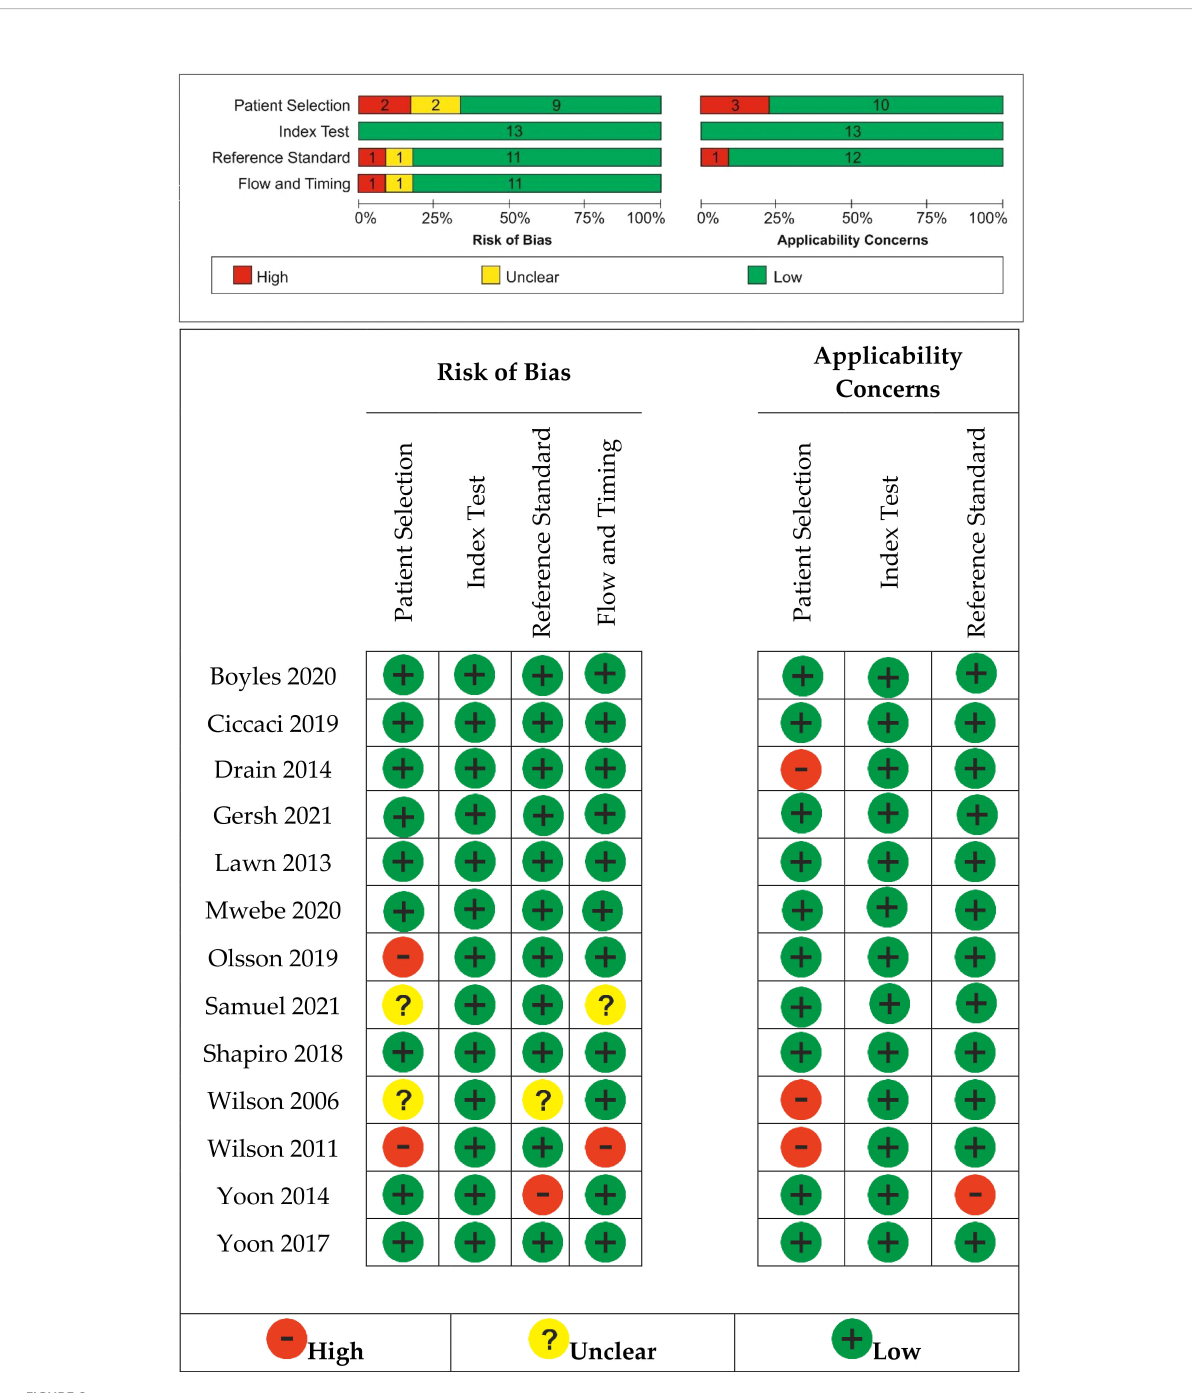
FIGURE 2 Risk of bias and applicability concerns summary: review authors ’ judgments about each